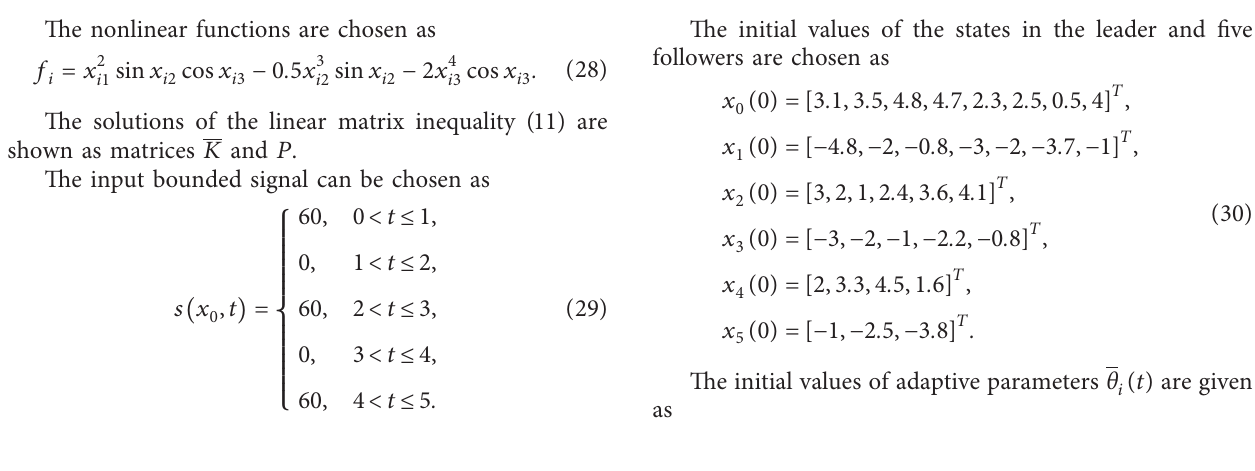
and followers x i ( i � 1 , 2 , 3 , 4 , 5; h � 1 , 2 , 3 , 4; k � 1 , 2 , 3; d � 1 , 0